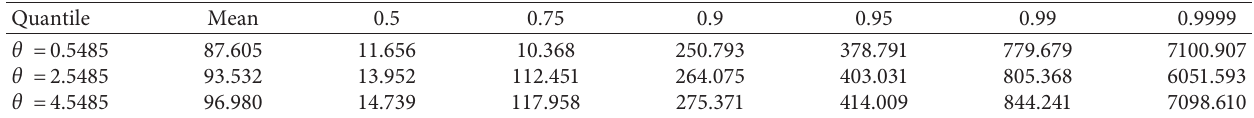
Table 5: Effect of dependence θ